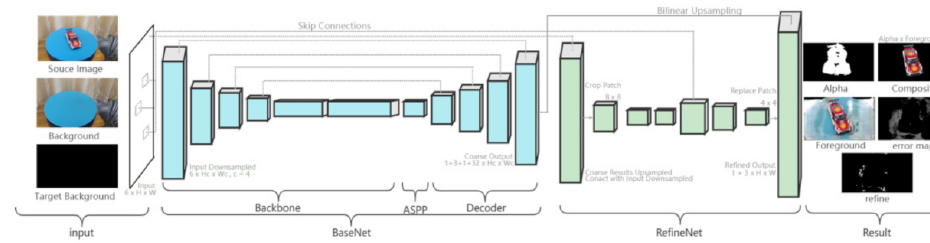
Figure 3. The two network structures of BGMv2 and the input and output